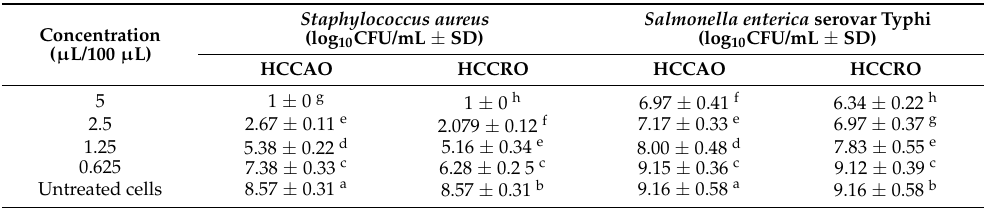
Table 15. Colony-forming unit (CFL/mL) of Staphylococcus aureus and Salmonella enterica serovar Typhi by essential oils from the aerial and rhizome part of H. coccineum